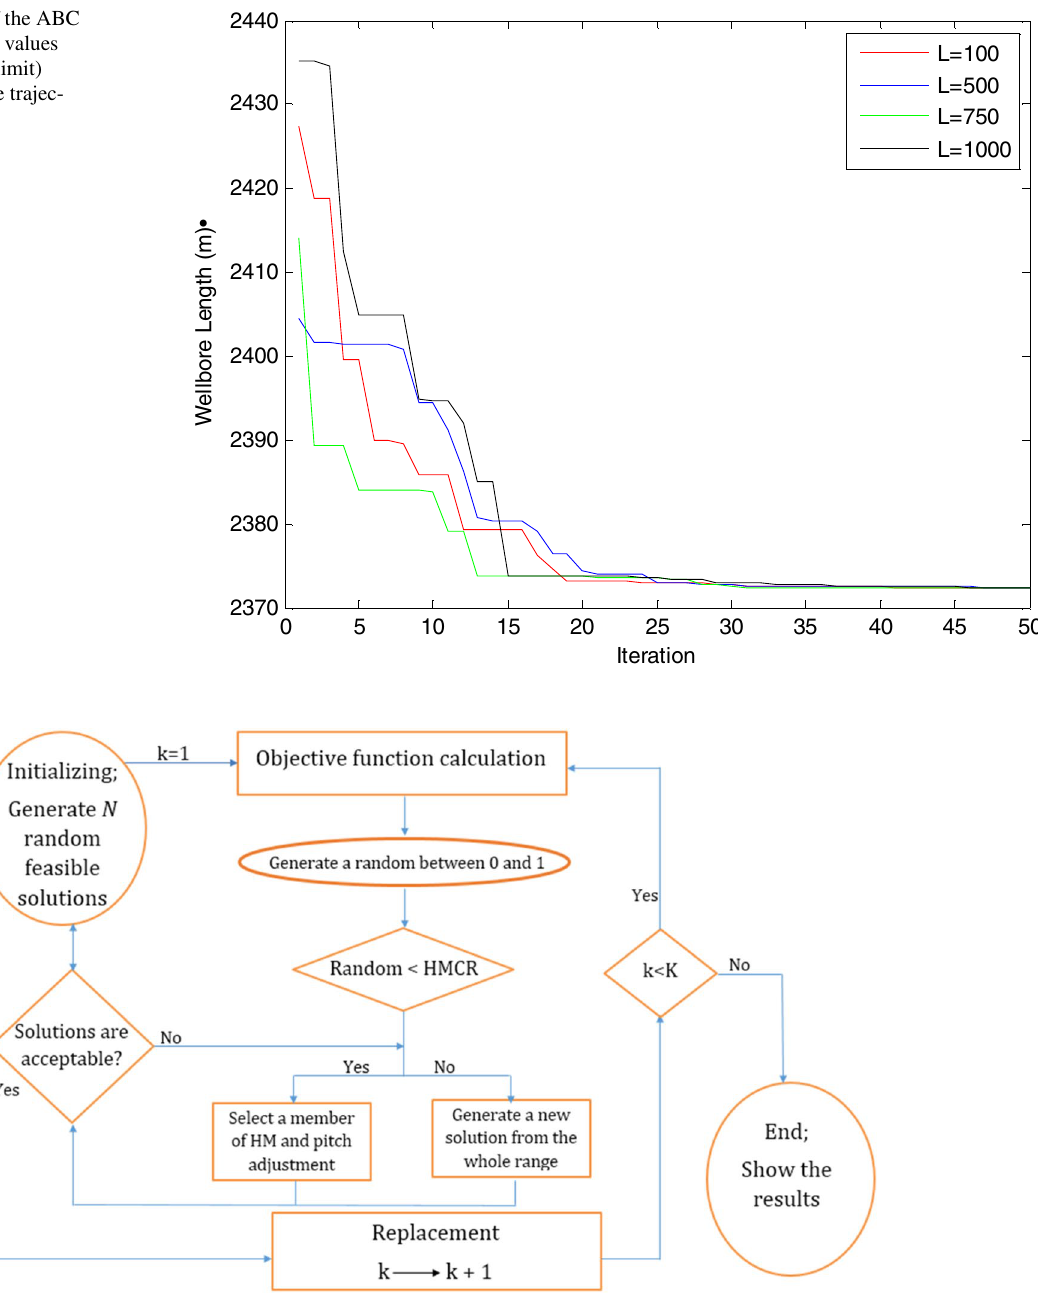
Fig. 9 Performance of the ABC algorithm for different values of “L” (abandonment limit) applied to the wellbore trajec- tory (Case 1)